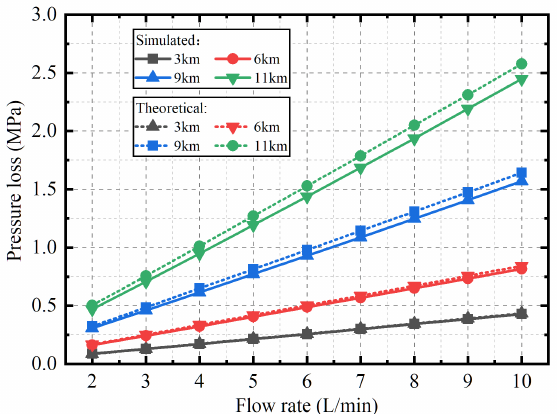
Figure 7. Validation of pipeline pressure loss.